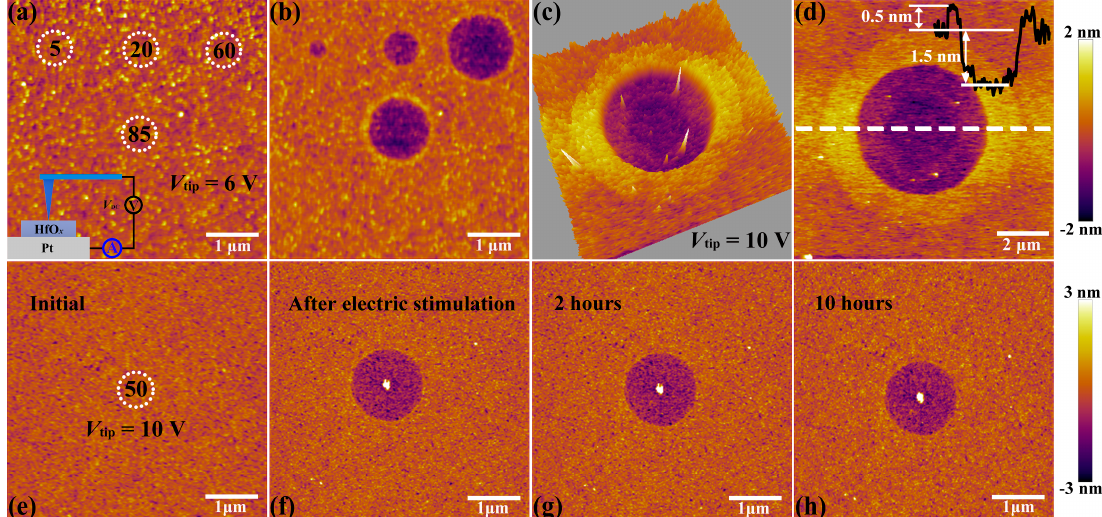
Figure 2. ( a ) Topographic atomic force microscopy (AFM) image of the locations (white dotted circle) where voltage sweepings were performed with the amplitude of 6 V for 5, 20, 60, 85 times, respectively (insert shows the schematic of the conductive atomic force microscopy (C-AFM) measurements). ( b ) Topographic AFM image of the HfO x nanofilm after stimulated by voltage sweepings up to 6 V during preceding C-AFM measurements for 5, 20, 60, 85 times, respectively. ( c ) Three dimensional and ( d ) two dimensional topographic images of the HfO x nanofilm after stimulated by C-AFM with a voltage sweepings of 10 V in an area of 1 × 1 μ m 2 . Insert shows the height and depth of HfO x nanofilm from the AFM cross-sectional profile along the white dotted line. ( e ) Topographic image showing the position where voltage sweepings were performed with the amplitude of 10 V for 50 times. ( f – h ) Topographic images after removing the electrical stimuli for 0, 2, 10 h, respectively.